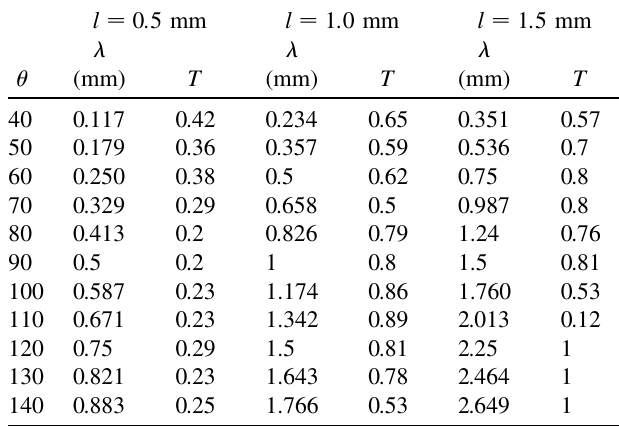
TABLE I. List of the filter transmission efficiencies applied to the experimental data for various observation angles and differ- ent grating periodicities ( l ). All wavelengths are for order 1.